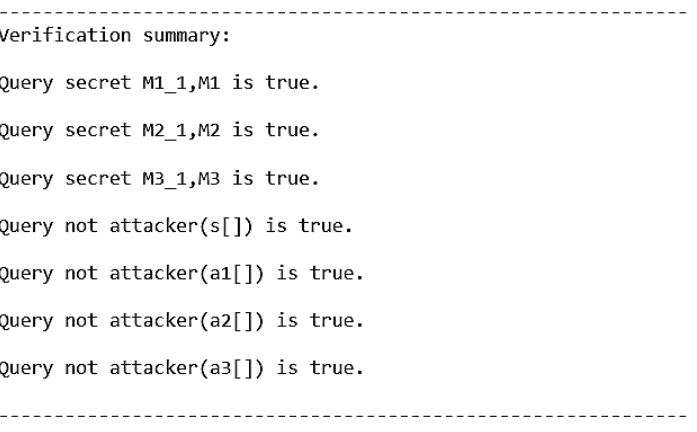
Figure 7. The PV simulation results of our